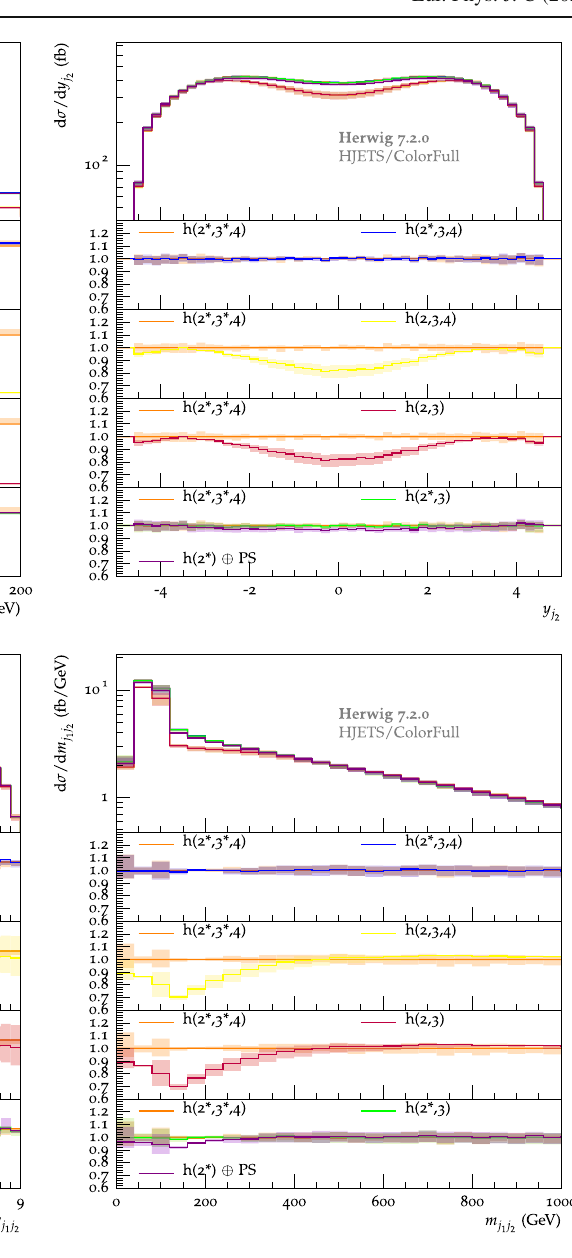
Fig. 6 Shown is the distribution of 2 jets observables with INCL selec- prediction is h ( 2 (cid:3) , 3 (cid:3) , 4 ) , h ( 2 (cid:3) , 3 , 4 ) , h ( 2 , 3 , 4 ) , h ( 2 (cid:3) , 3 ) , h ( 2 , 3 ) , and (cid:2) h ( 2 (cid:3) ) tion cuts: transverse momentum (top left) p T , j and rapidity y j (top PS with h ( 2 (cid:3) , 3 (cid:3) , 4 ) being the reference in the ratio plots. 2 2 right) for the second leading jet, rapidity gap Δ y j Shown in the figures are theory error bands due to the variation of (bottom left) 1 j 2 the factorization and renormalization and invariant mass m j (bottom right) of the two tagging jets. The 1 j 2